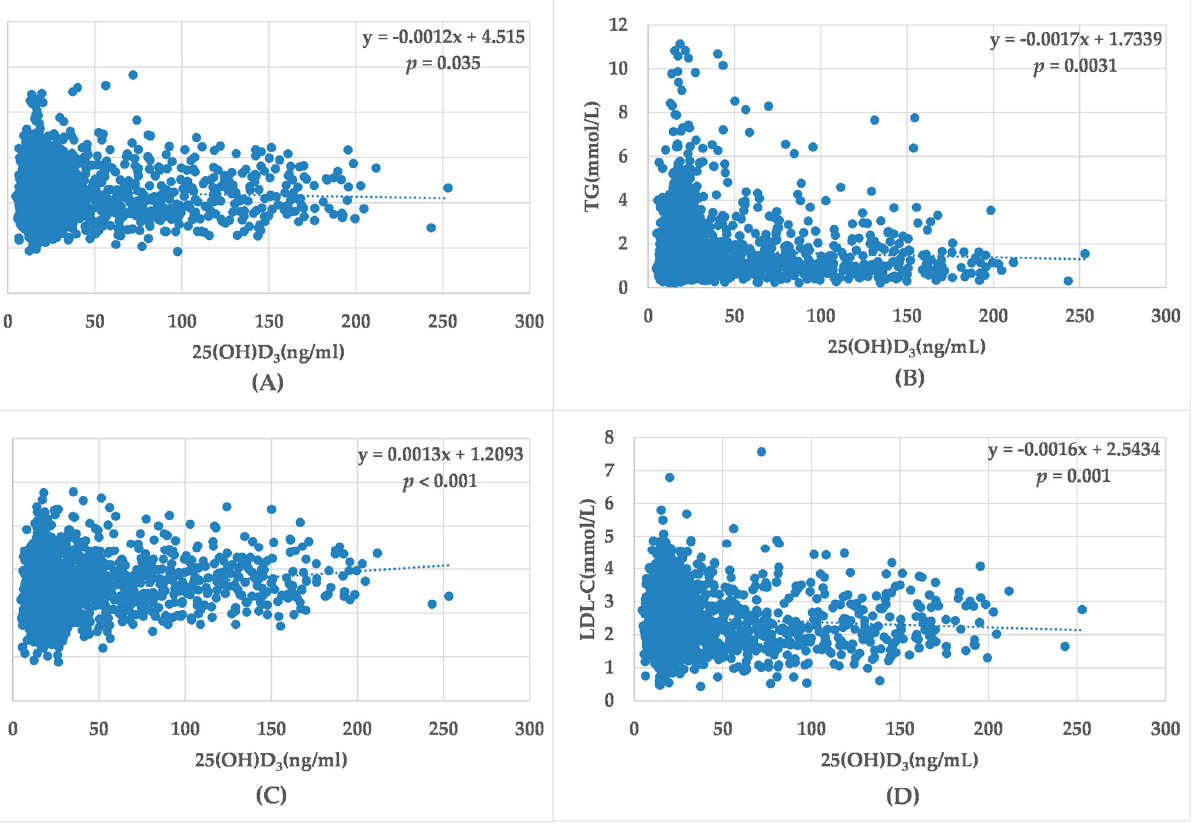
Table 2. OR and 95%CI for the risk of T2DM according to the levels of serum lipids. Unadjusted Parameter